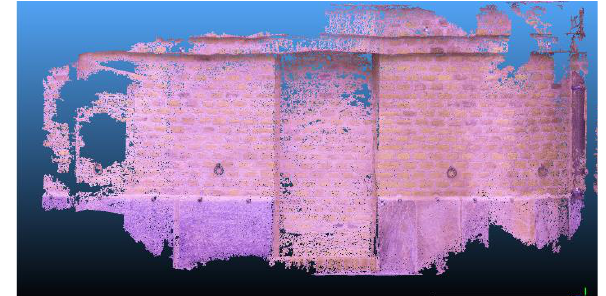
Figure 3: VSfM UVAb dense point cloud OBJ3